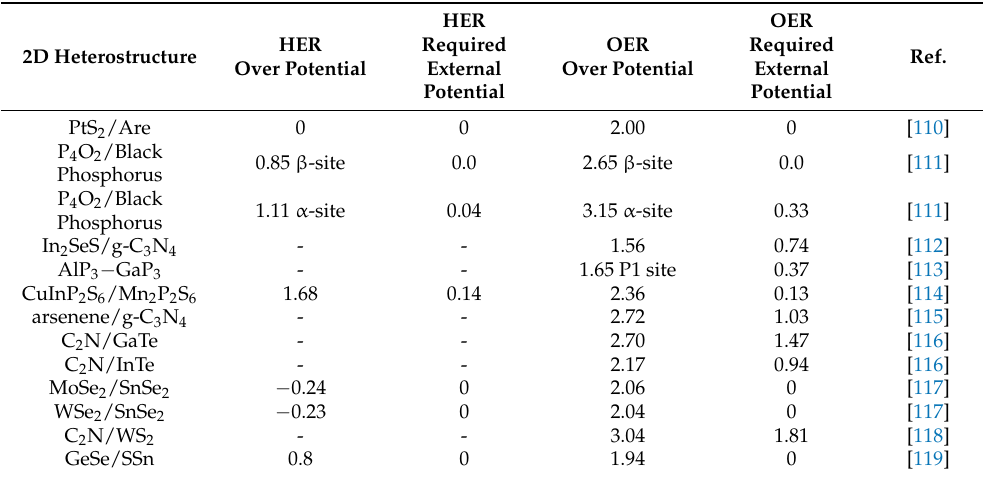
Table 2. Overpotential and required external potential for HER and OER for 2D